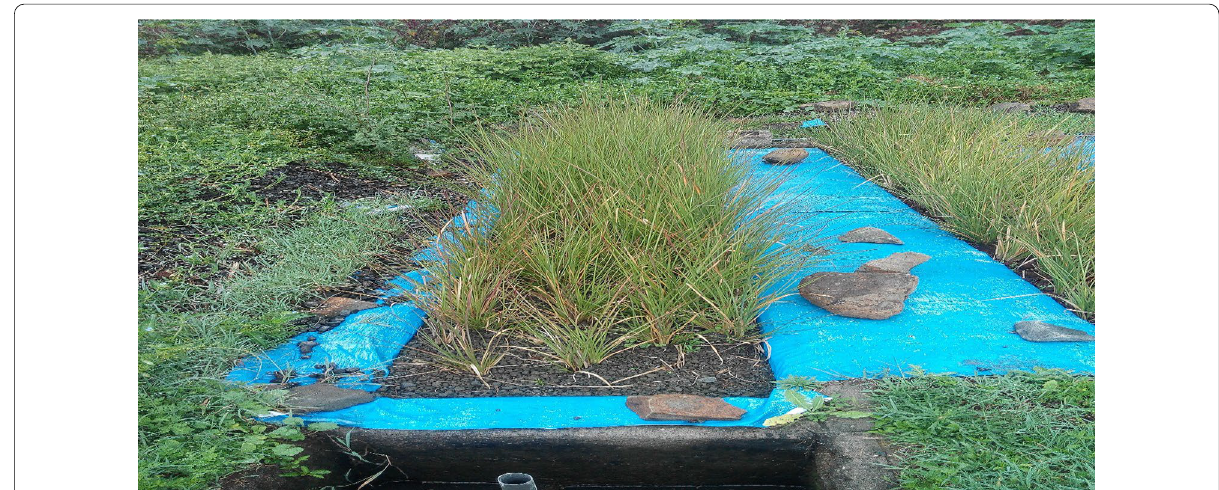
Fig. 4 Pumice and gravel substrate Bed (Photo by Mekonnen